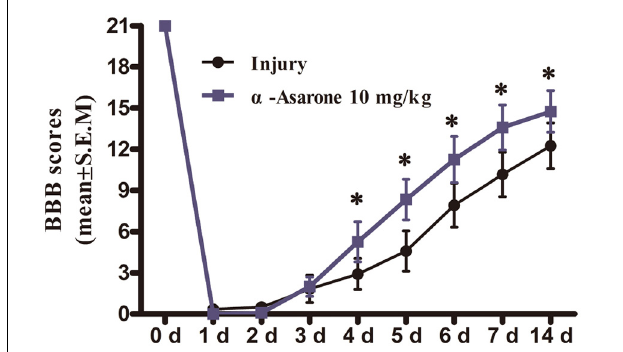
FIGURE 2 | The effect of α -asarone on locomotor assessment. Basso, Beattie, and Bresnahan (BBB) scores for rats in the SCI ( n = 6) and α -asarone-treated ( n = 6) groups at different time points (1, 2, 3, 4, 5, 6, 7, and 14 days) post-surgery. ∗ P < 0.05. Data are represented as the mean ± standard error of the mean and analyzed using Wilcoxon rank sum